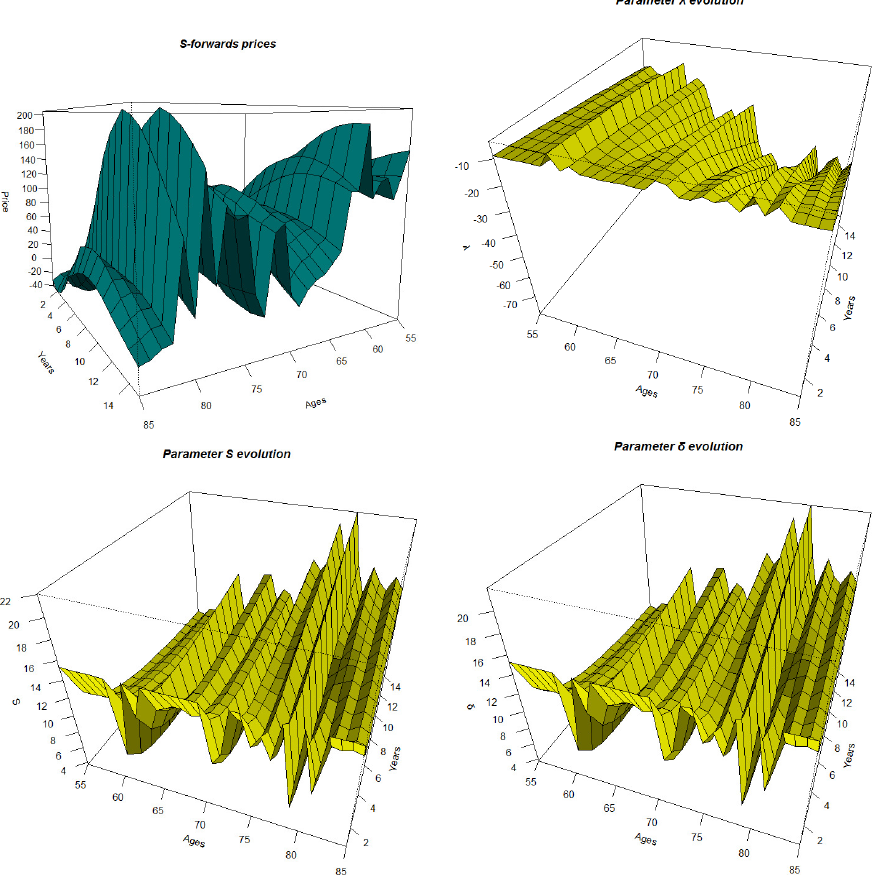
Figure A5. 3D presentation of the S-forwards prices and the corresponding parameters with the other methods.